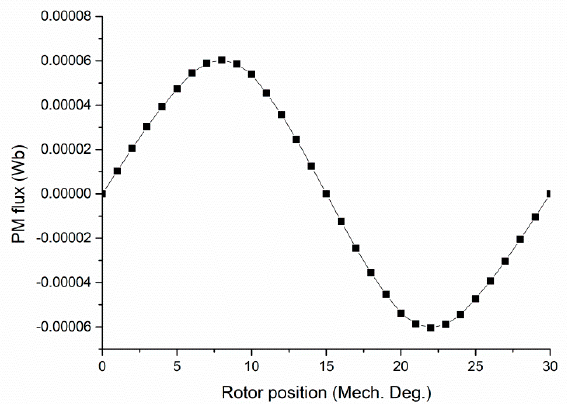
Figure 4. PM flux per turn of FRCPM.